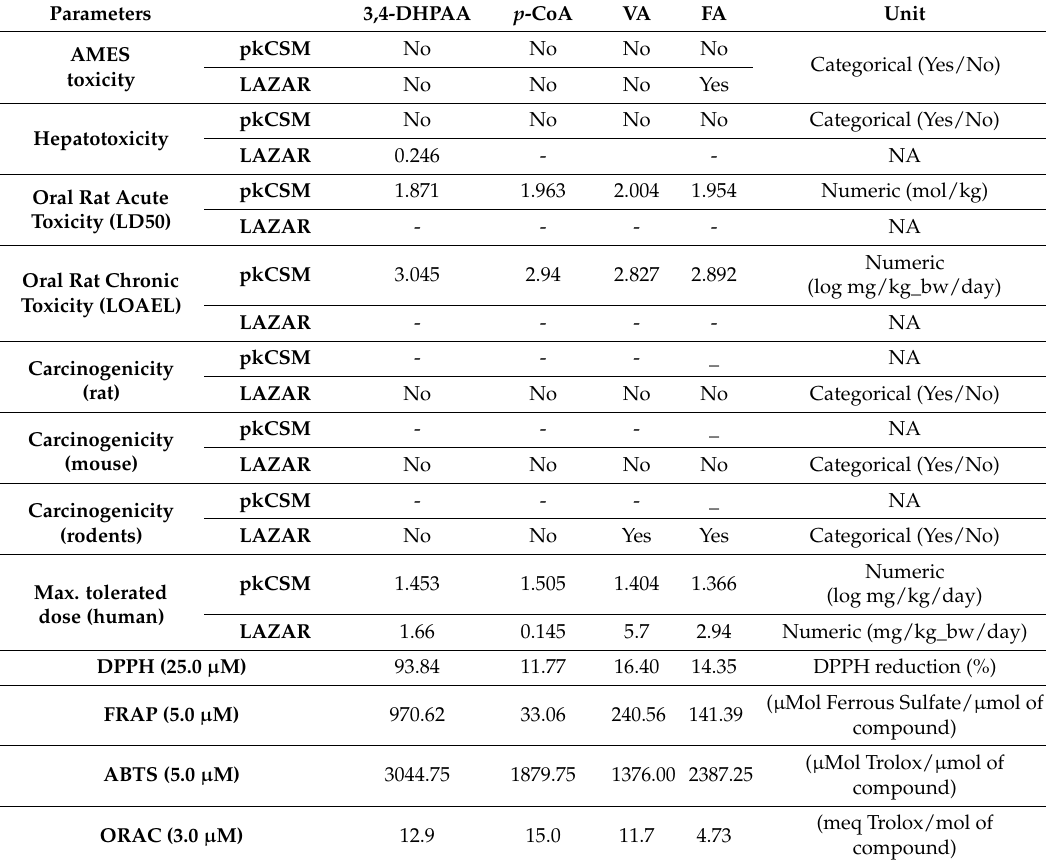
Table 1. Comparison between pKCSM and LAZAR toxicity prediction, and antioxidant activity of phenolic